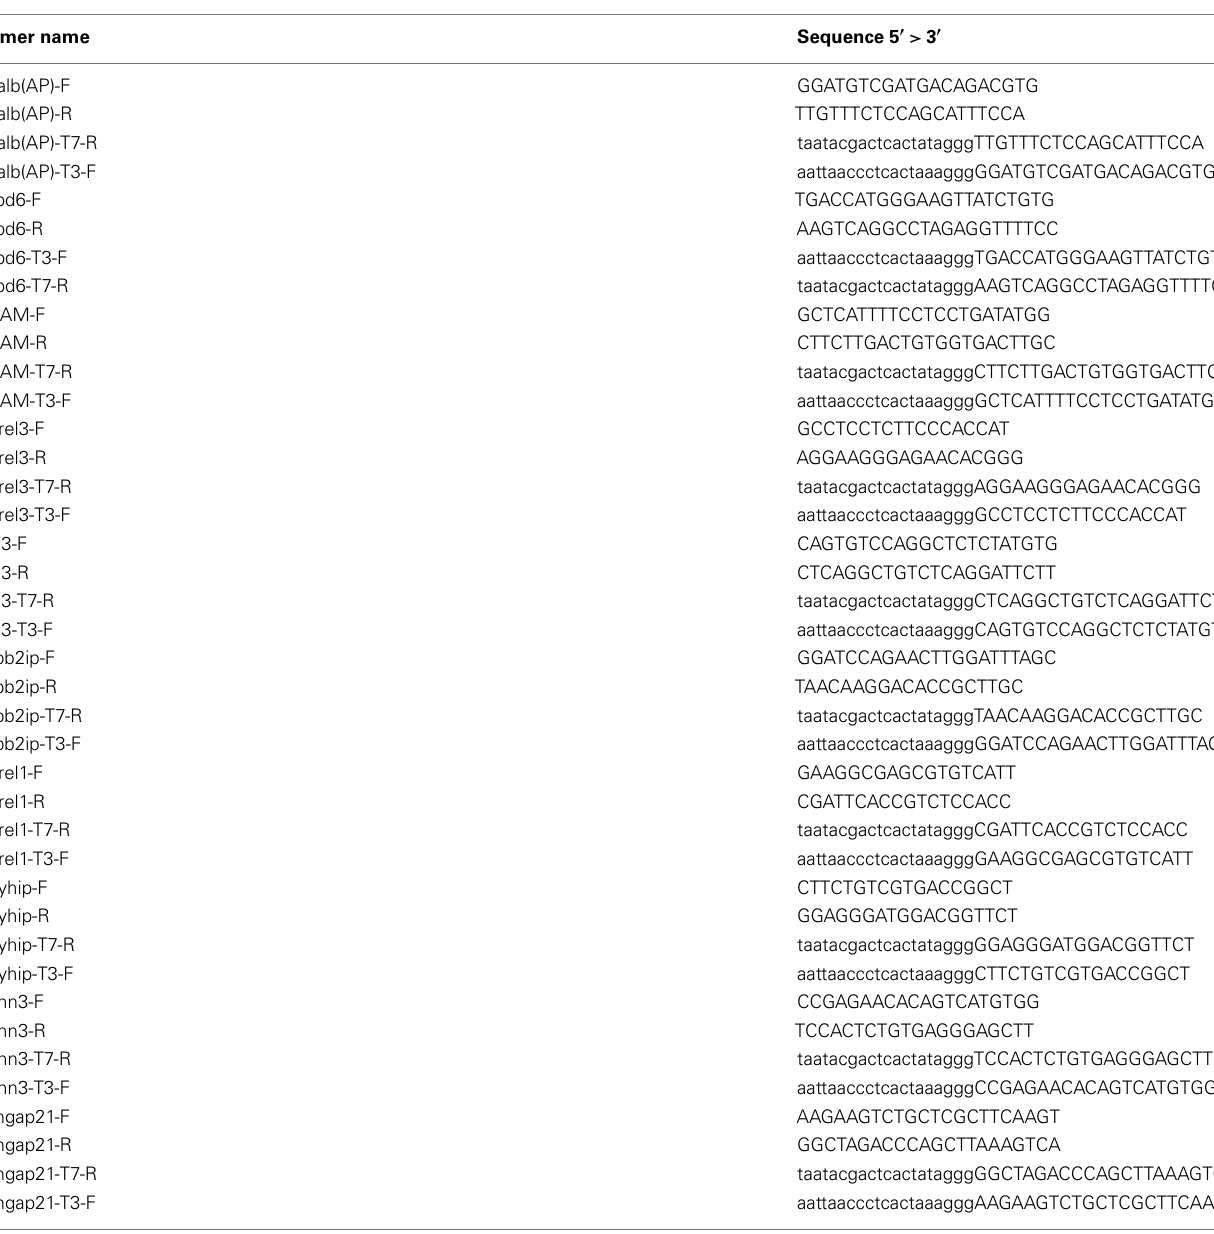
TableA2 | List of RNA in situ hybridization